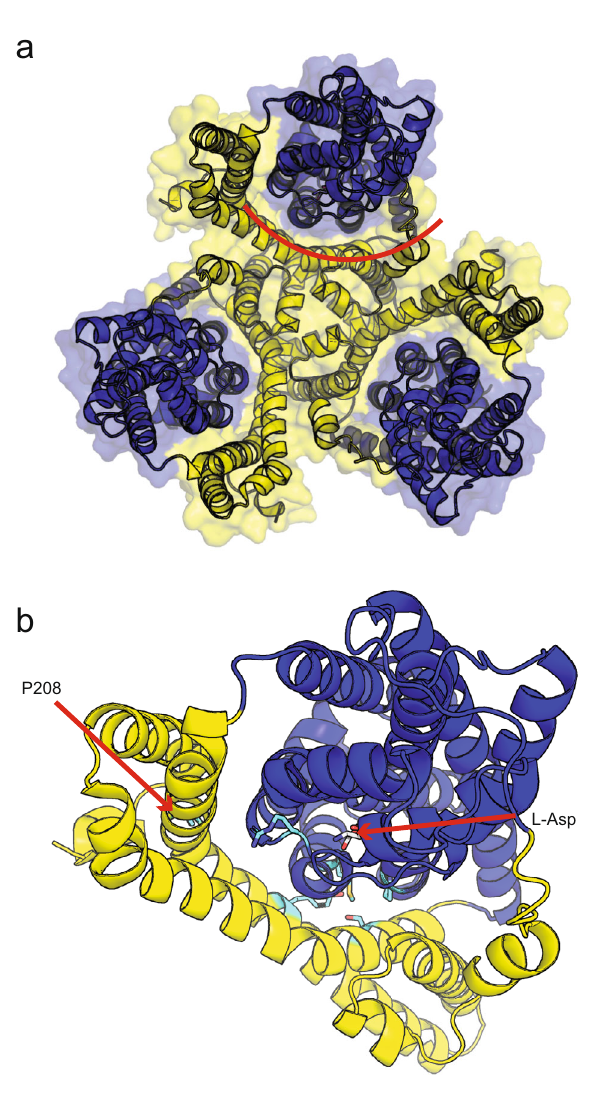
Fig. 1 | Trimeric assembly of Glt Tk and conservation of the chloride channel. a ThegeneralarchitectureofGlt Tk comprisedoftrimerizationdomains(yellow)and thetransportdomains(blue),viewfromtheextracellularsideofthemembrane.The red line indicates the interface (in one of the protomers), where the anion- conducting channel is formed during the elevator movement of the transport domain. b Zoom-inontooneoftheprotomers(sameorientation);residuesinvolved intheformationoftheporeareshownincyansticks,positionsofthesubstrateL-Asp and P208 (homologous to P290 in hEAAT1) are indicated with the red